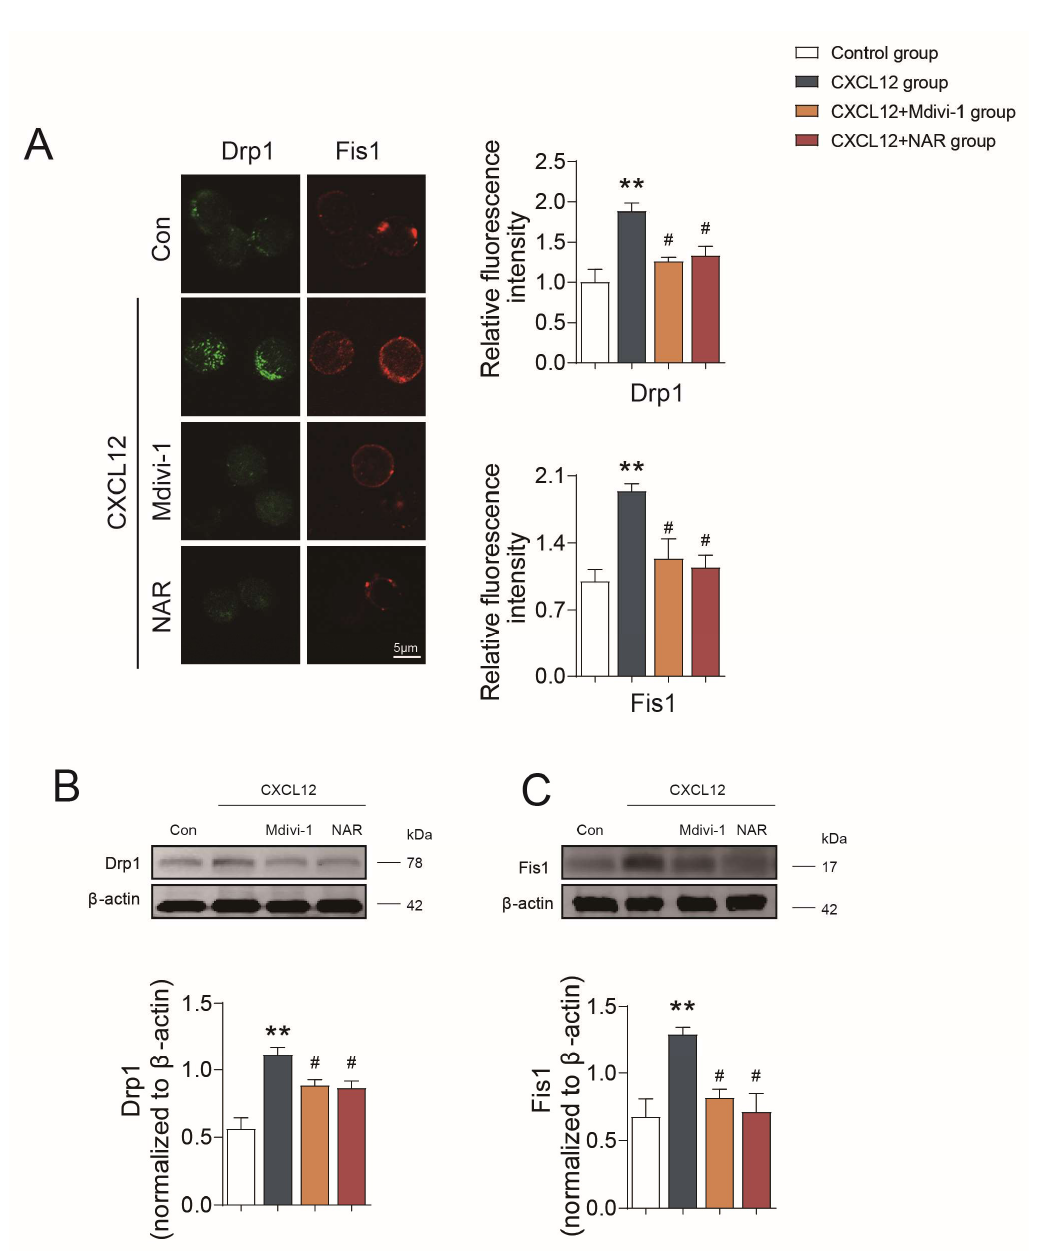
Figure 8. NAR inhibited the mitochondrial fission of primary CD4 + T lymphocytes. ( A ) Drp1 and Fis1 as measured by immunofluorescence. Representative Western blots showing the expression of Drp1 ( B ) and Fis1 ( C ) in the CD4 + T lymphocyte in different groups. ** p < 0.01 vs. control group, # p < 0.05 vs. CXCL12 group, by repeated-measures one-way ANOVA followed by post hoc Dunnett’s multiple comparisons test. All scale bars are 5 µm. The data are presented as means ± SEM (n = 3–4 mice per group, 3 sections and 3–5 different fields of each section were randomly selected for semi-quantitative